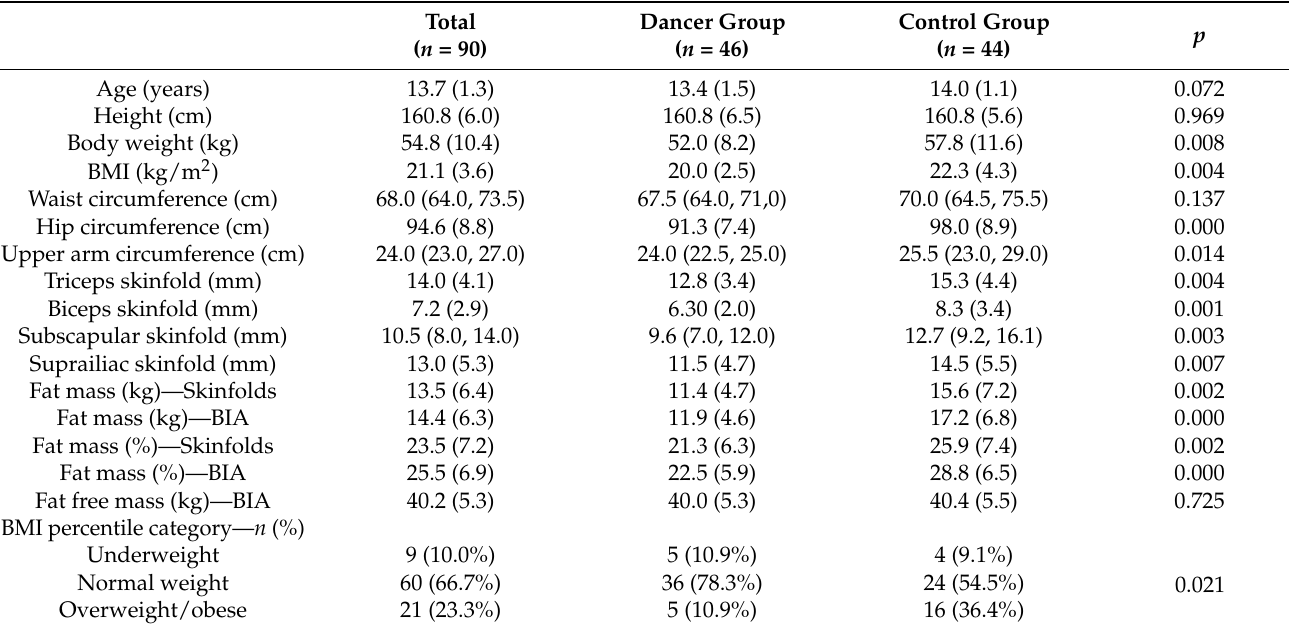
Table 1. Participant ages and anthropometric